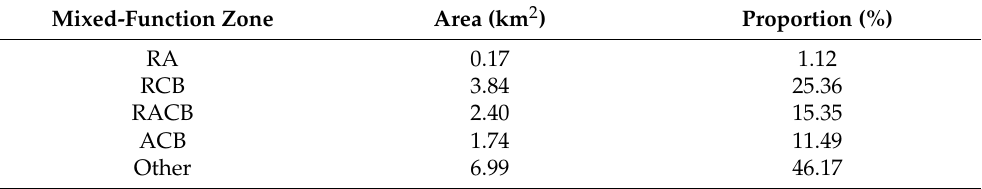
Figure 8. Distribution of mixed-function zones. Table 2. Proportion of each mixed-function zone. RA, RCB, RACB, ACB, and other mixed-function zones. Mixed-Function